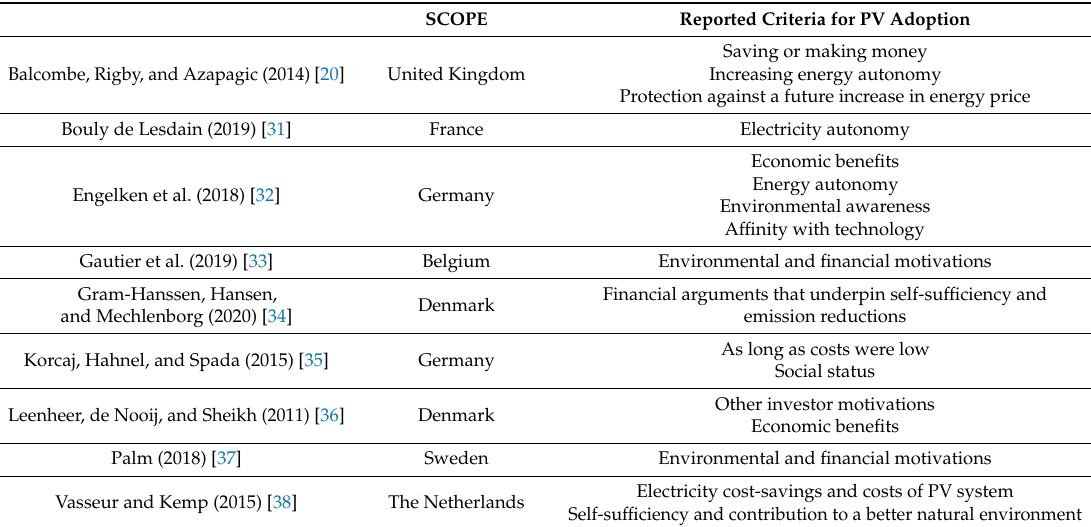
Table 2. Recent studies related to European self-consumption adopters. PV: Photovoltaic. SCOPE Reported Criteria for PV Adoption Balcombe, Rigby, and Azapagic (2014)